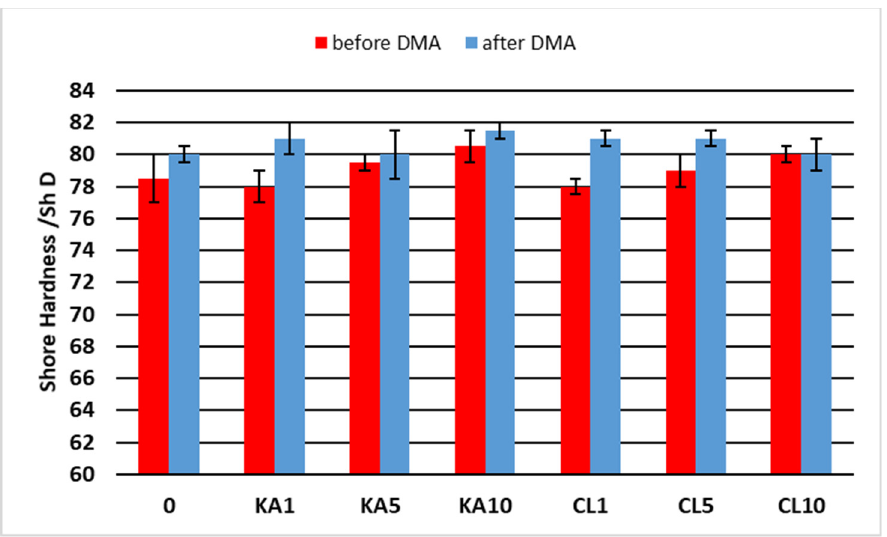
Figure 10. The hardness of the obtained materials.